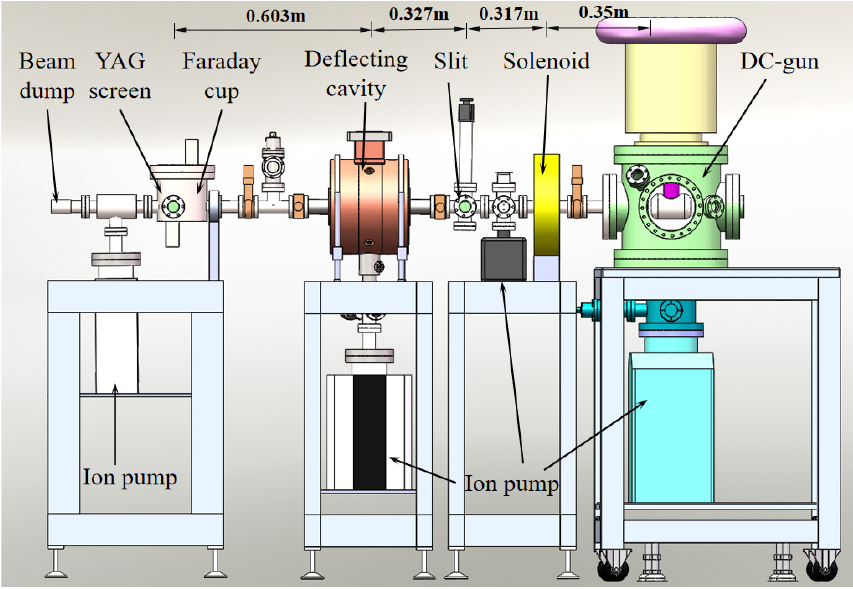
Figure 5. The design of the bunch length measurement beamline.